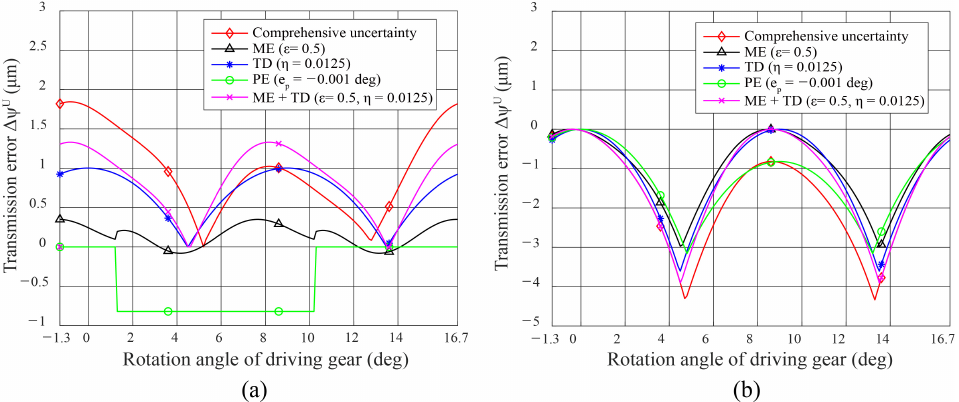
Figure 17. Transmission error of plastic spur gear pair under ( a ) unloaded and ( b ) loaded conditions (Comprehensive uncertainty: (cid:101) = 0.5, η = 0.0125, e p = − 0.001 deg, ME : (cid:101) = 0.5, η = 0, e p = 0 deg, TD : (cid:101) = 0, η = 0.0125, e p = 0 deg, PE : (cid:101) = 0, η = 0, e p = − 0.001 deg).